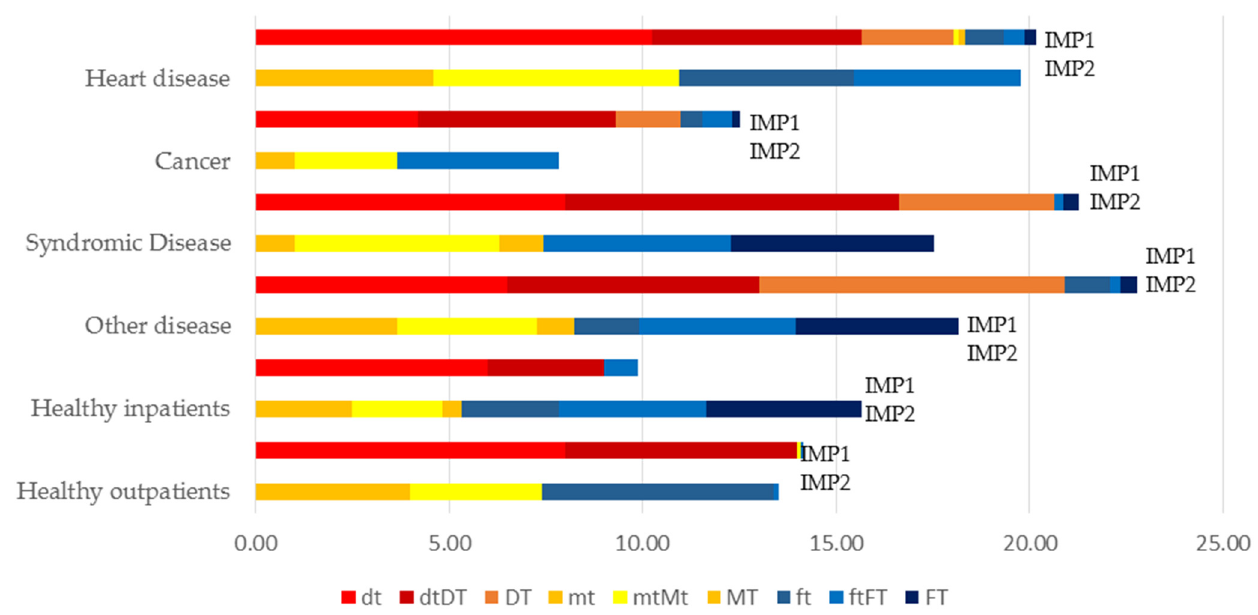
Figure 4. dmf-t/DMF-T index of school children at first impulse (IMP1-pre-operative assessment) and at second impulse (IMP2-dental treatment under GA): decayed (dt), missing (mt), and filled (ft) teeth for sole primary dentitions; decayed (dtDT), missing (mtMT), and filled teeth (ftFT) for mixed dentitions; decayed (DT), missing (MT), and filled (FT) teeth for sole permanent dentitions.